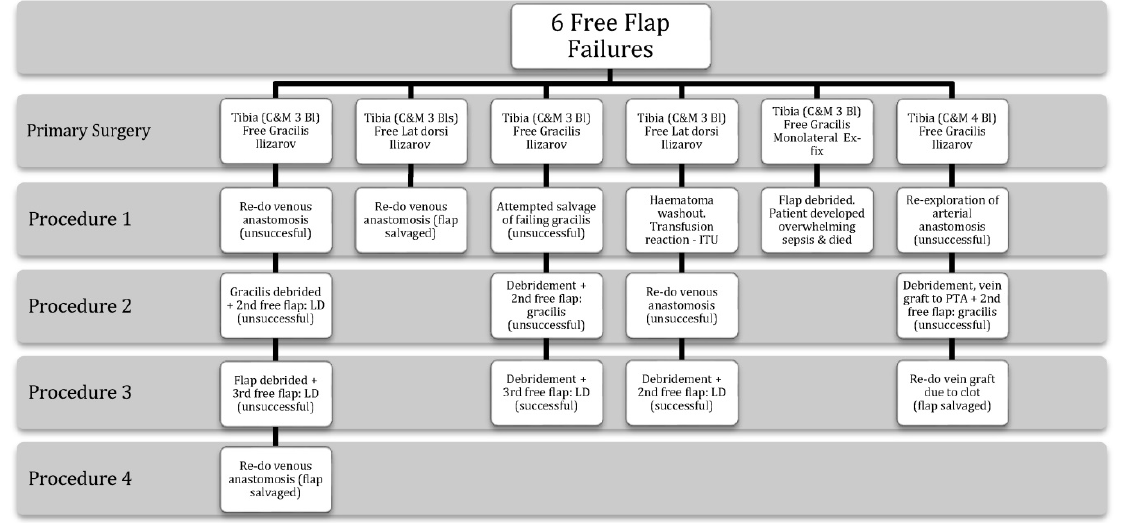
Figure 3 : The individualised sequence of events for the six patients who developed primary free flap